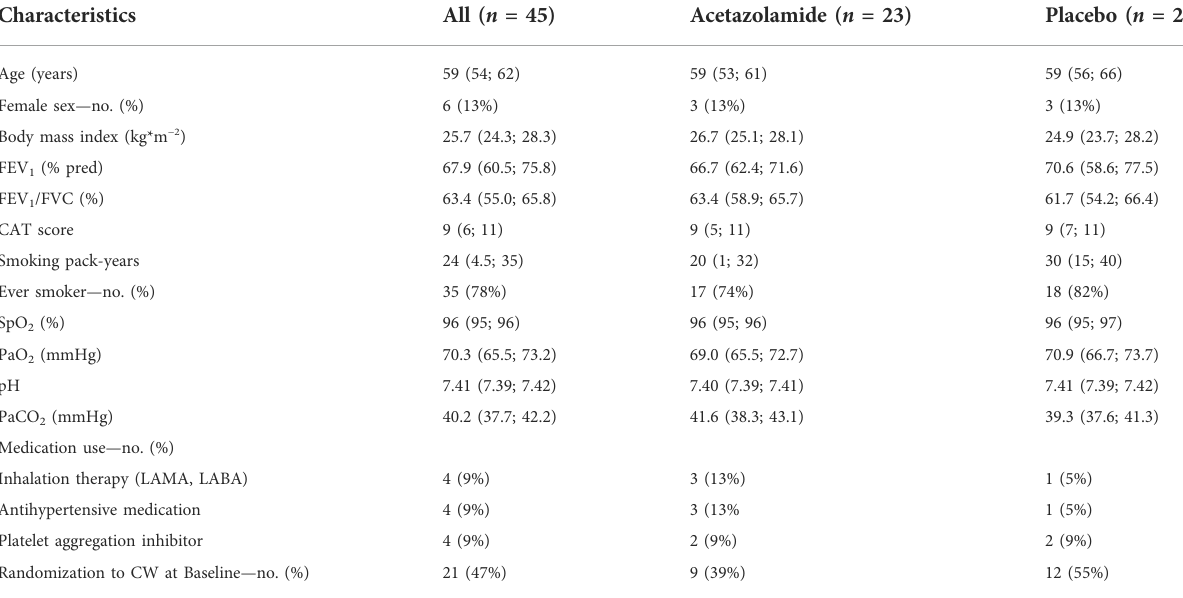
TABLE 1 Baseline characteristics of patients (per protocol analysis). Characteristics